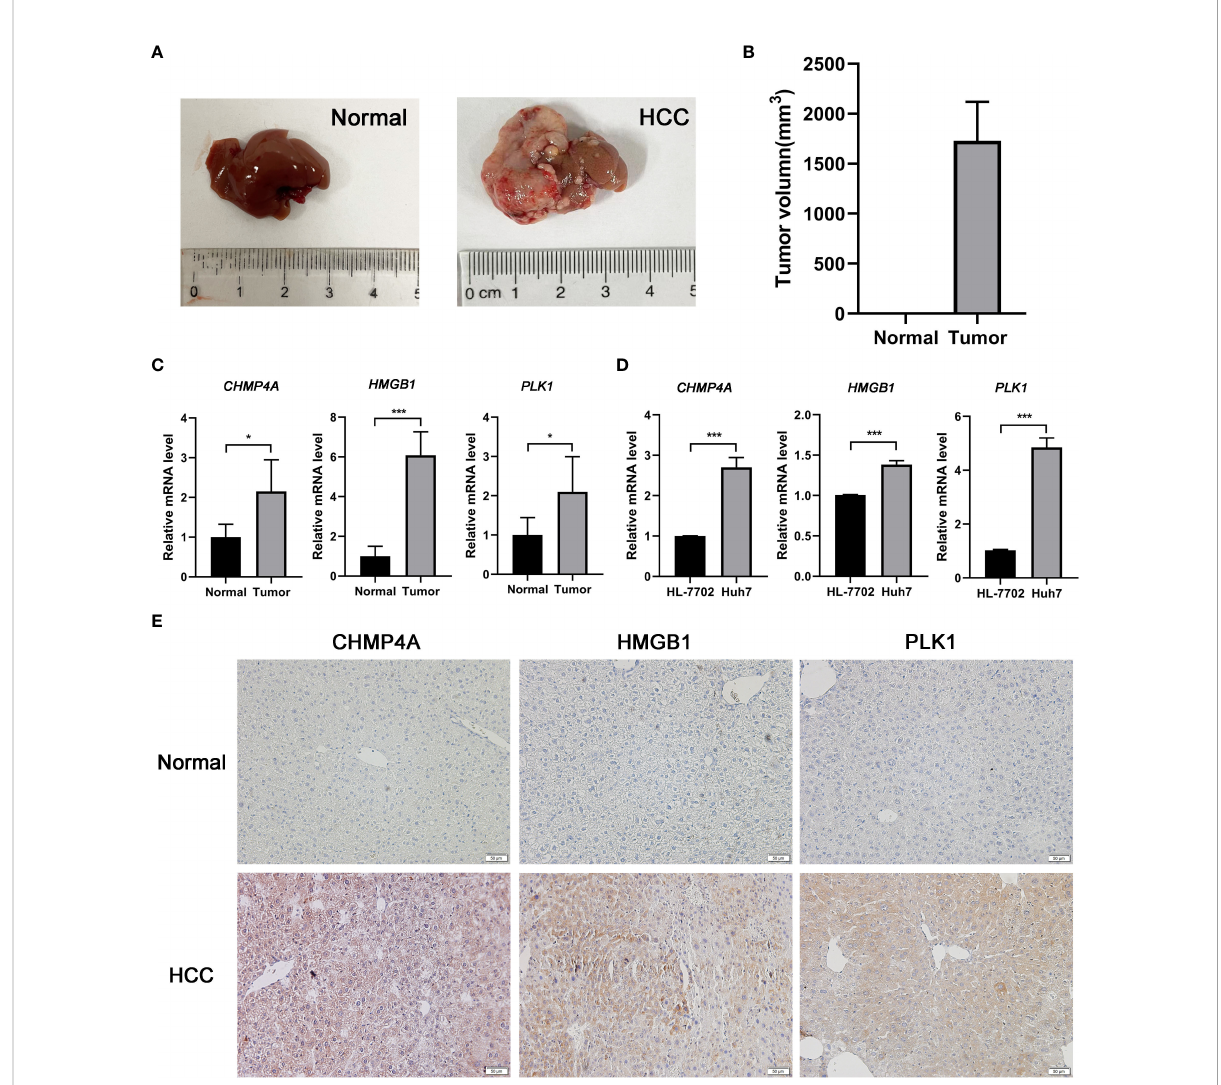
FIGURE 9 Validation of the differential expression of the three prognostic genes in vivo and in vitro . (A) Typical diagrams of normal and tumor liver tissue from mice were presented. (B) Tumor volumes between normal and HCC models from mice were measured. (n = 5, per group) (C) The mRNA levels of CHMP4A , HMGB1 and PLK1 were detected in the normal and HCC livers of mice. (n = 5, per group) (D) The mRNA levels of CHMP4A , HMGB1 and PLK1 were assessed between HL-7702 and Huh7 cells. (n = 3) * P < 0.05; *** P < 0.001. (E) The expression of CHMP4A, HMGB1 and PLK1 was determined in HCC tissues and non-tumor tissues from human samples performed by